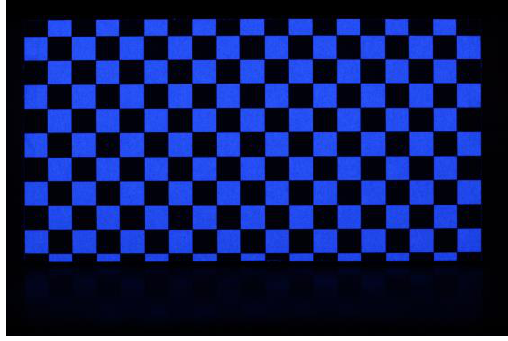
Figure 7: Checkerboard photographed by the device